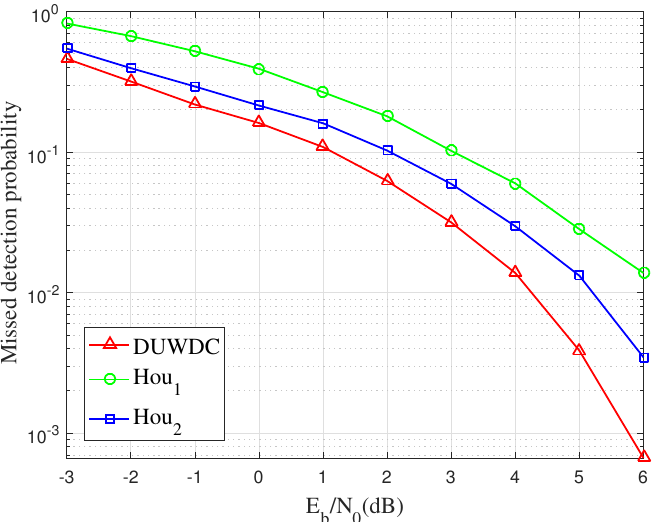
Figure 14. Relationship curve between the missed detection probability and SNR. To verify the robustness of the algorithm, based on DUW TDMA signal, DUWDC, Hou 1 and Hou 2 are simulated and compared. Simulation conditions: normalized frequency offset f e T = 0.1, E b / N 0 = − 1dB, the total number of UW is 48 symbols and the number of symbols inserted in each group is 2, 4, 6, 8, 12 and 16. Monte Carlo experiments are carried out on this signal. Under the threshold of false alarm probability P f < 10 − 5 , the detection probabilities P d of each algorithm under different UW distribution structures are counted, respectively. The experimental results are shown in Figure 15.